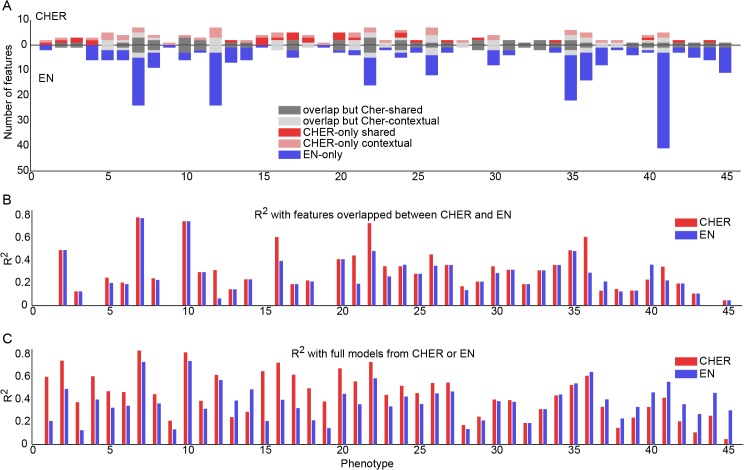
Comparison of features selected by CHER and elastic net (EN).A. Number of features selected by both and individual algorithms for each phenotype. For each phenotype (x-axis), numbers of features selected by CHER are represented on the positive y-axis whereas those selected by elastic net are represented on the negative y-axis. Features are separated into five groups, corresponding to features selected by both algorithms or by specific to individual algorithms. Phenotype 1–14 are from CCLE-SkinGlioma and the rest are from CCLE-Blood. B. Adjusted R2 of CHER and elastic net models using the features selected by both algorithms (features of the first two categories in A). C. As B, but all features selected by each algorithm are used. Phenotypes in all three figures are sorted by the difference of R2 between CHER and elastic net from C.